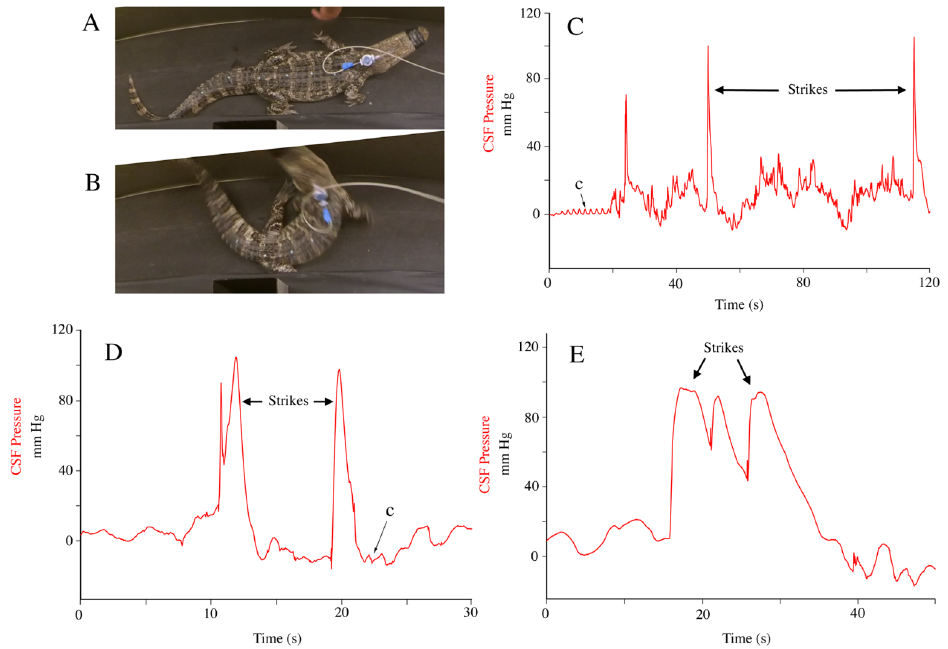
Figure 11. Defensive strikes of Alligator mississippiensis produced increases in CSF pressure. ( A , B ) isolated frames of a 150 cm A. mississippiensis moving both the tail and head to produce a sharp bend in the body while performing a defensive strike; there is 0.18 s between the two frames. ( C – E ) are records of defensive strikes performed by separate animals; in each case the elevation of CSF fluid pressure (red) during the strike is distinct from the cardiac-related pulsations. c—individual cardiac-related